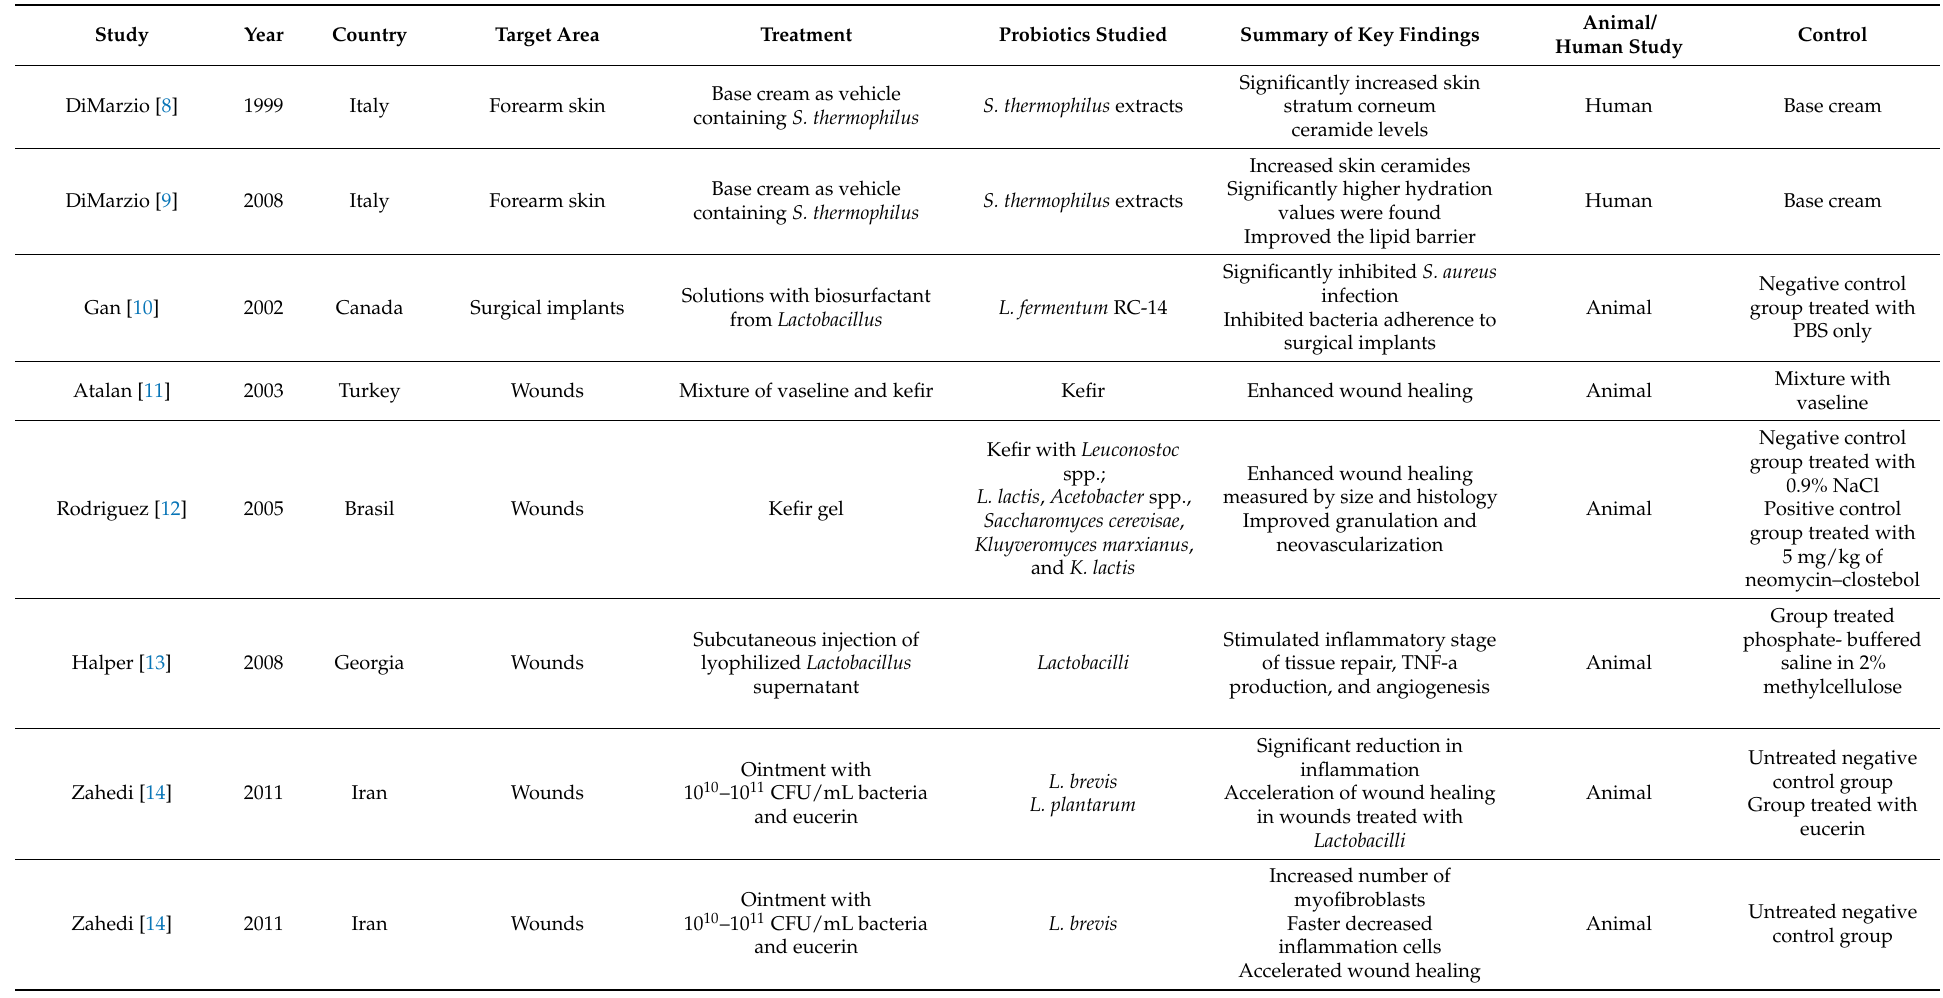
Table 1. Detailed summary of human and animal studies included. All the outcomes noted are significantly different from the control groups applied in every